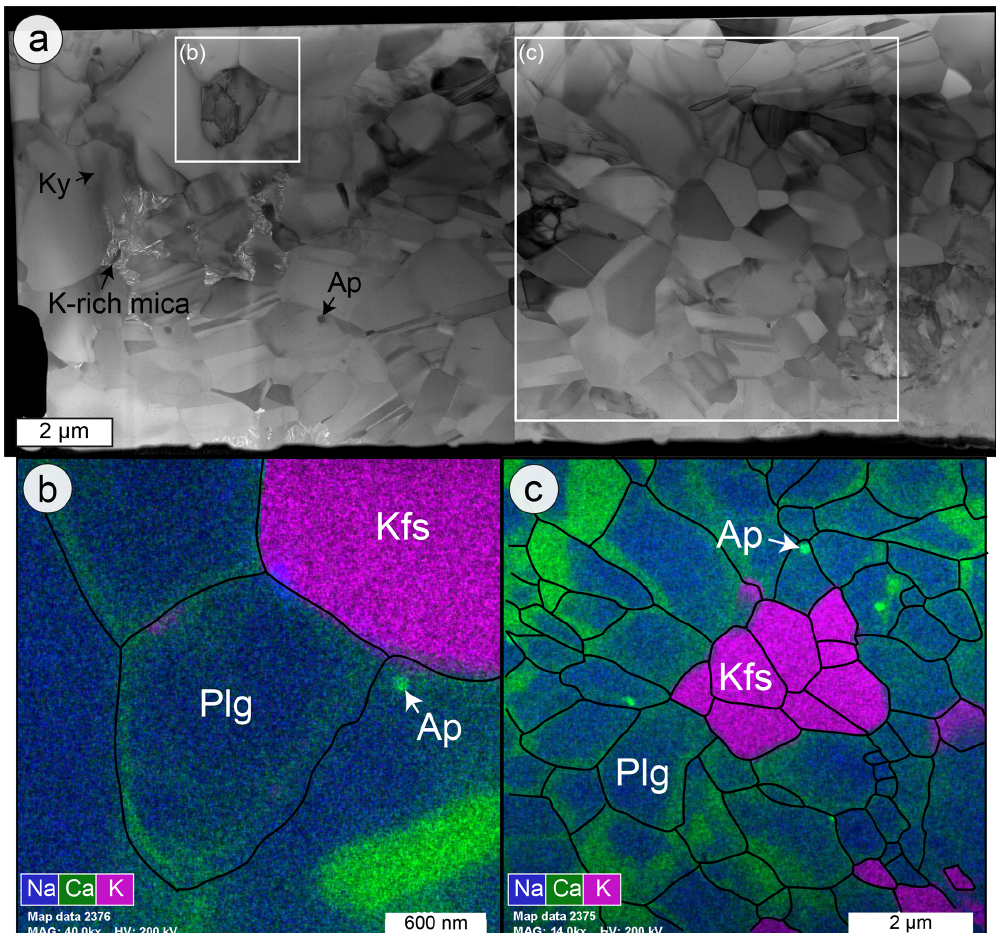
Figure 7. Microstructures of MF2. (a) Bright-field image of the entire FIB cut from Fig. 1e. The plagioclase (Plg) microfracture contains dislocation-free grains with some twins. (b) EDX map of a dislocation-rich grain overlain with grain and phase boundaries (black). (c) EDX map of the area in panel (a) overlain with grain and phase boundaries (black). The Ca-rich domains are present along grain boundaries.